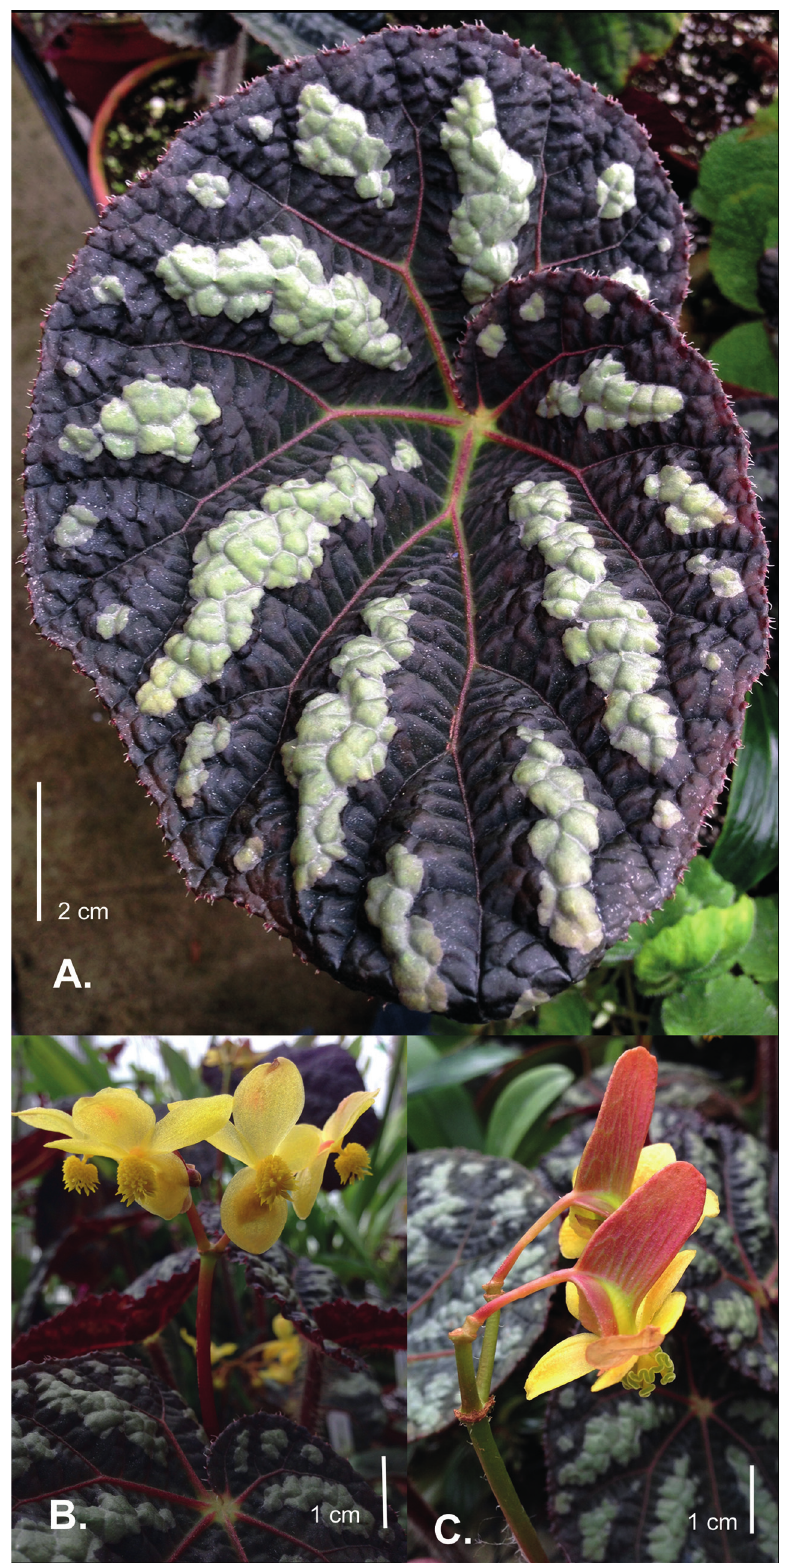
Fig. 66. Begonia xanthina Hook. A . Dark leaf form. B . Male flowers. C . Female flowers. Photographs courtesy of Darrin Norton of a plant in cultivation in a private